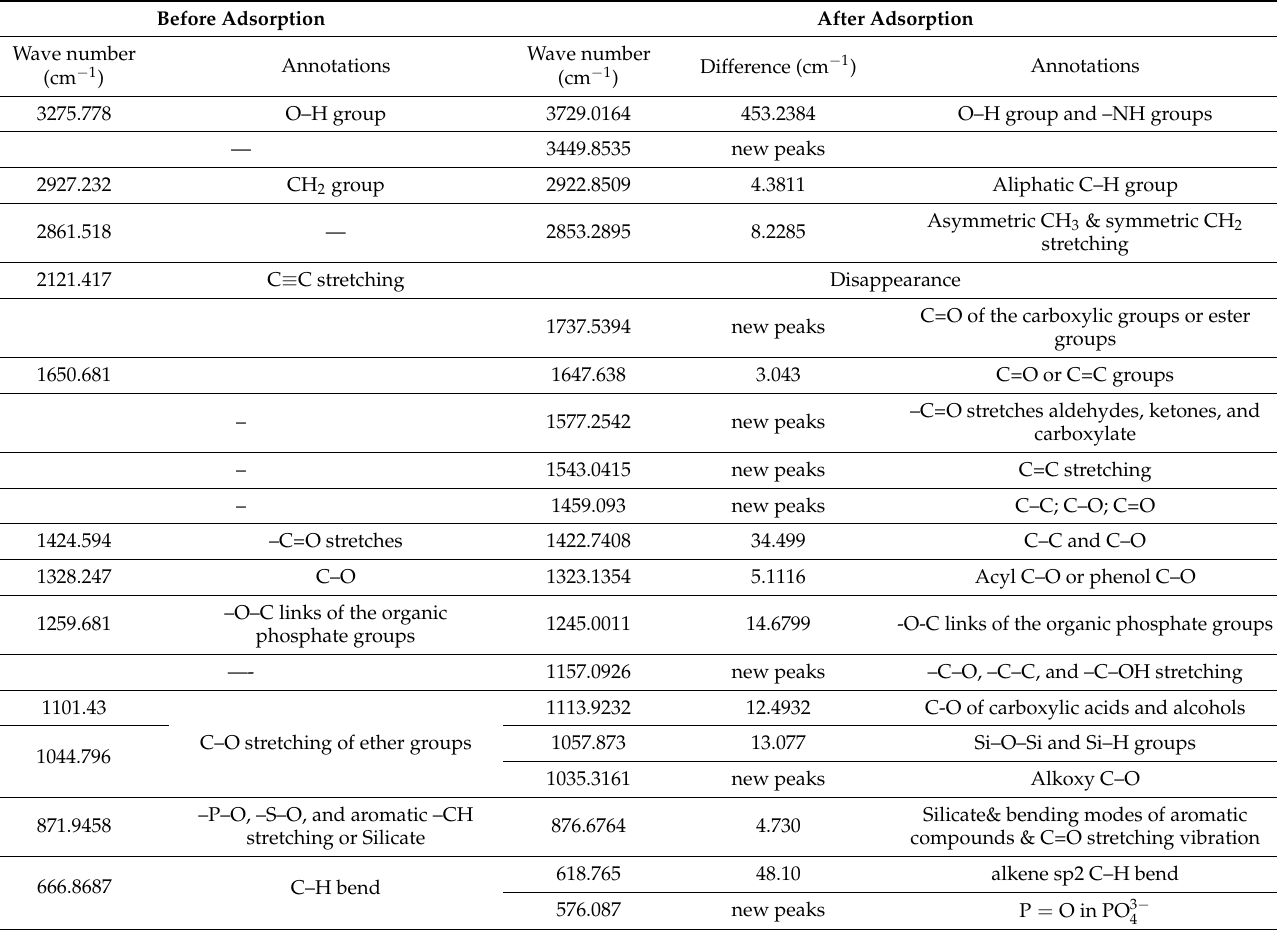
Table 1. Frequency and annotations of FTIR spectroscopy analyses of P. capillacea nanoparticles before and after adsorption of IV2R